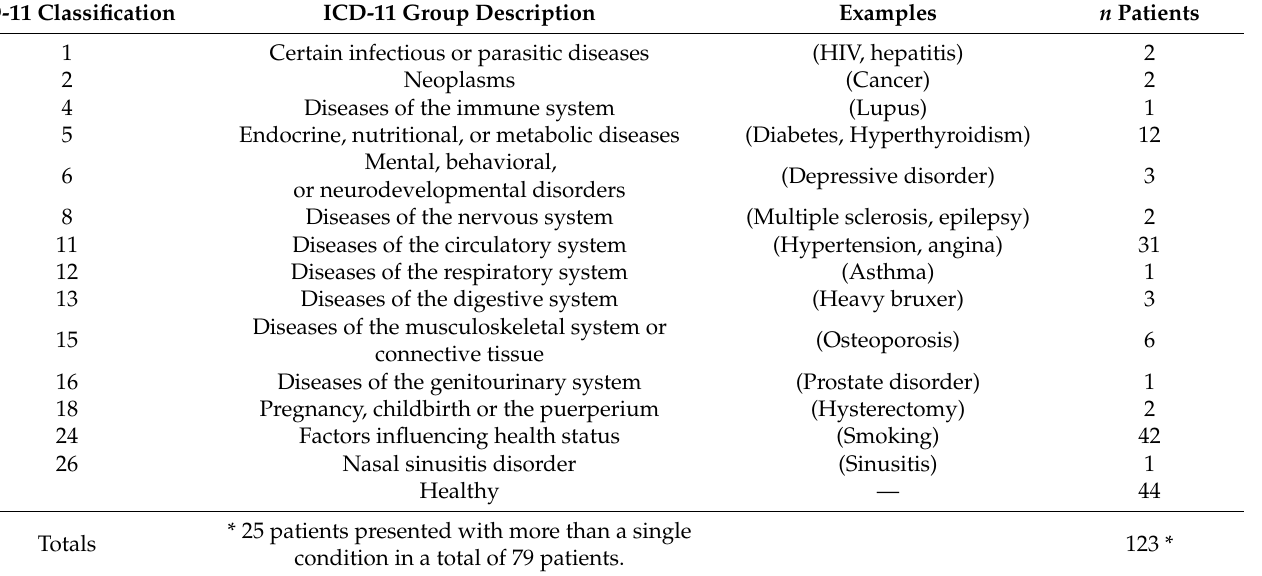
Table 1. Overall medical status distribution according to the International Classification of Disease, version 11 (ICD-11) and implant distribution in the